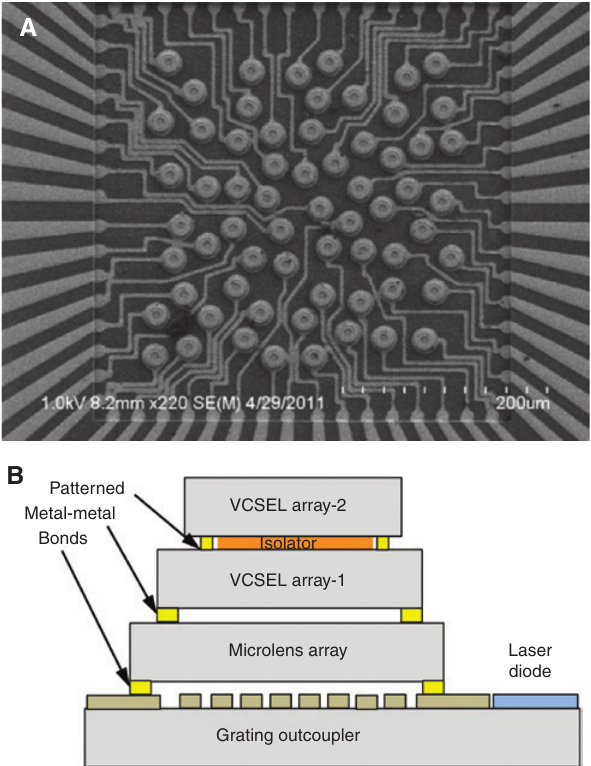
Figure 16: (A) Scanning electron microscopy image of a 64-element non-uniformly spaced VCSEL array, including metal interconnect lines. (B) Schematic of a vertically integrated OPA, including two layers of optically coupled VCSEL arrays. The VCSELs are injection locked to a single, vertically coupled, master laser that is focused on the VCSELs by a microlens array. Reprinted by permission of The Optical Society [61].